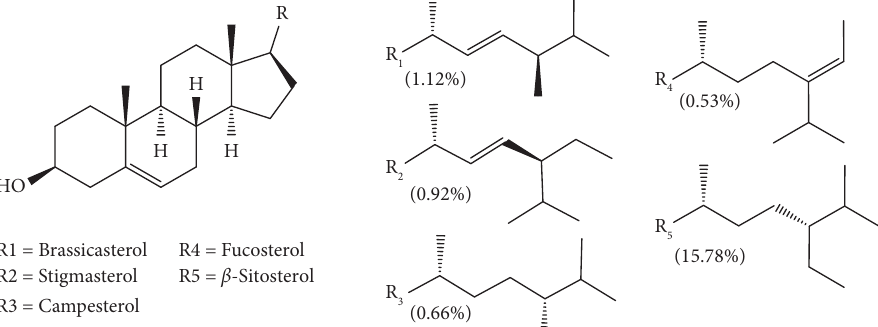
Figure 2: Structures of phytosterols identifed in the saponifed diethyl ether extract of pili pulp oil. Values in parenthesis denote relative abundance in percent of total ion count.